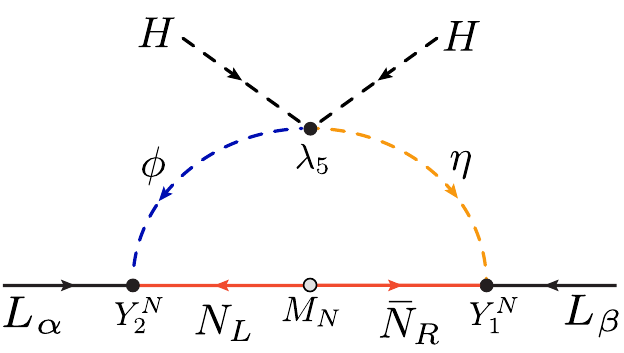
Figure 1 . Diagram generating neutrino masses at one-loop in our model, analogous to the original scotogenic model. Fields running in the loop are charged as 3 the external legs (SM) transform as 3